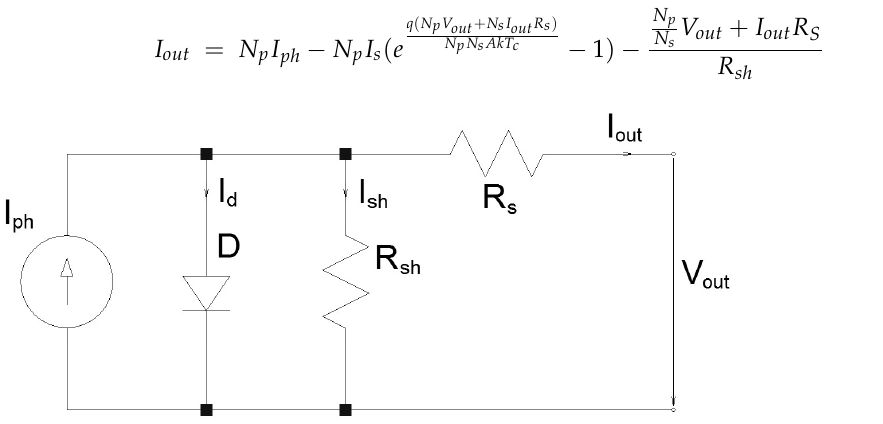
Figure 6. Equivalent circuit of advanced or practical PV simulation model.